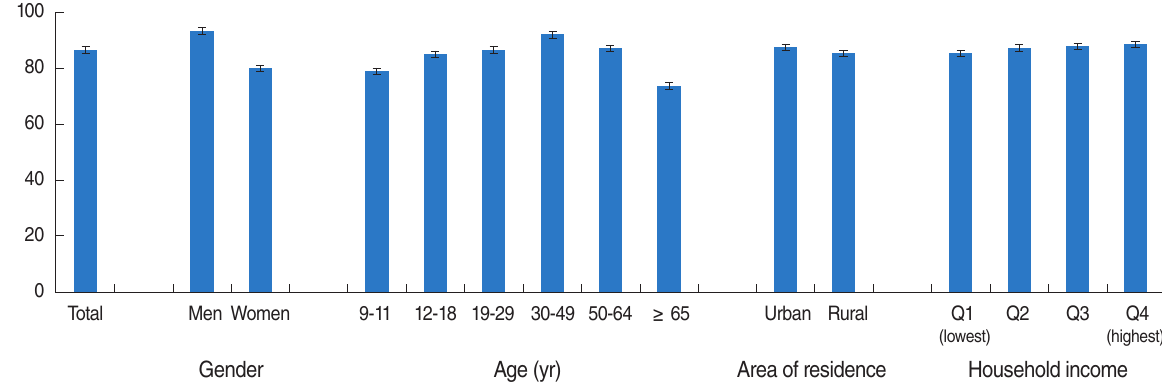
Figure 2. Prevalence of excessive sodium intake compared to the Korean Dietary Reference Intake among Koreans above 9 years of age, the 2012 Korea National Health and Nutrition Examination Survey. Values are presented as percentages and confidence intervals. The goal for sodium intake of Korean Dietary Reference Intake was established at 2,000 mg/d for those above 9 years of age. The age-standardized prevalence according to the area of residence and household income was calculated using an estimated population, based on the 2005 census of the Korean